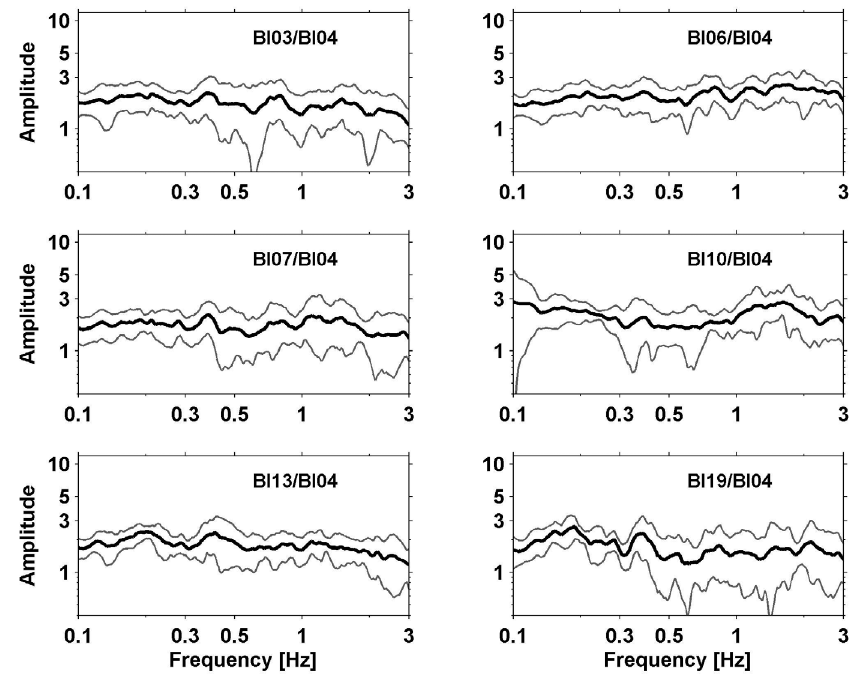
Figure 8. Same as Figure 6, except for the southern and south-east sectors (see Figure 5).